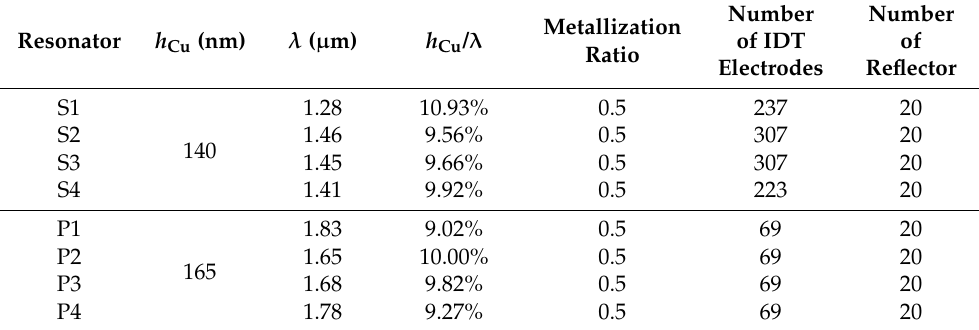
Figure 6. ( a ) The filter topology; ( b ) simulated admittance curves of series and shunt resonators; ( c ) optical microscope of the fabricated filter; ( d ) simulated and measured frequency responses of the filter. Table 2. The design parameters of the SAW filter using the second IDT thickness-modulated configuration.